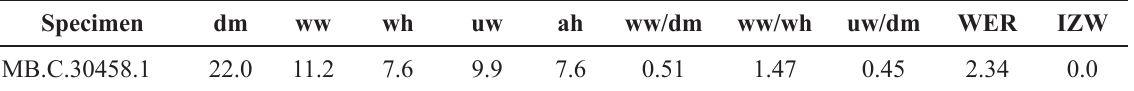
Table 5. Conch dimensions (in mm) and ratios of Stroboceras mane sp. nov.